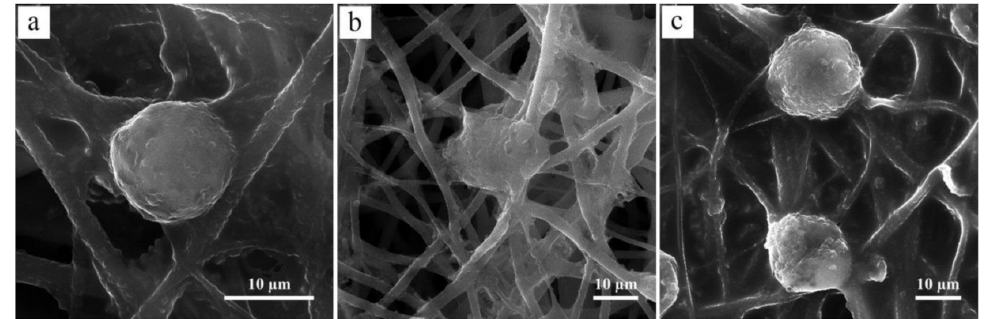
Figure 10. SEM images of cultured chondrocyte cells on the surface of ( a ) PHB, ( b ) PHB/15wt % CTS and ( c ) PHB/20wt % CTS scaffolds. Reproduced from [32] with permission from Wiley. Porous PHB/CTS scaffolds were fabricated and investigated [150]. The results demon- strated that PHB/CTS scaffolds supported chondrogenic differentiation of rat MSCs in vitro. Acellular PHB/CTS scaffolds were successfully utilized in vivo for the repair of artificially of hyaline cartilage-like tissue. Chondrocyte viability on the PHB/CTS/1 wt %